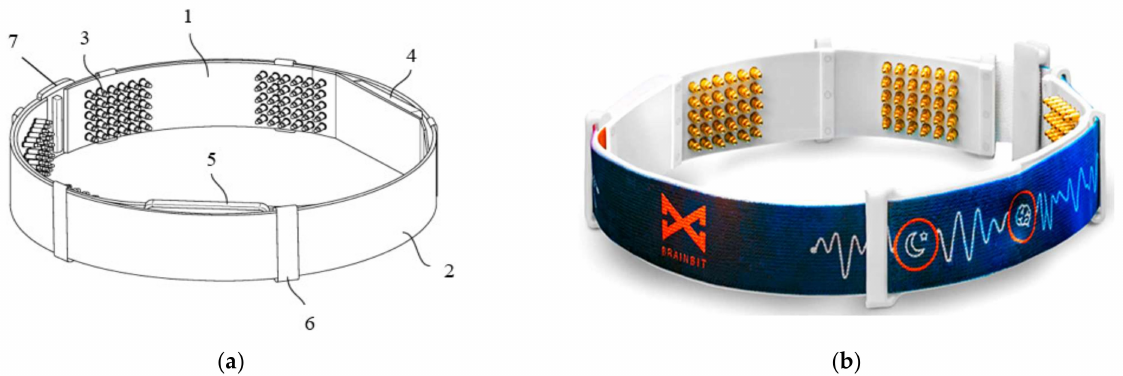
Figure 2. Schematic ( a ) and real ( b ) views of BrainBit (1: ribbon, 2: elastic band, 3: electrodes, 4: electronic module, 5: removable battery, 6: eyelet, 7: clasp)